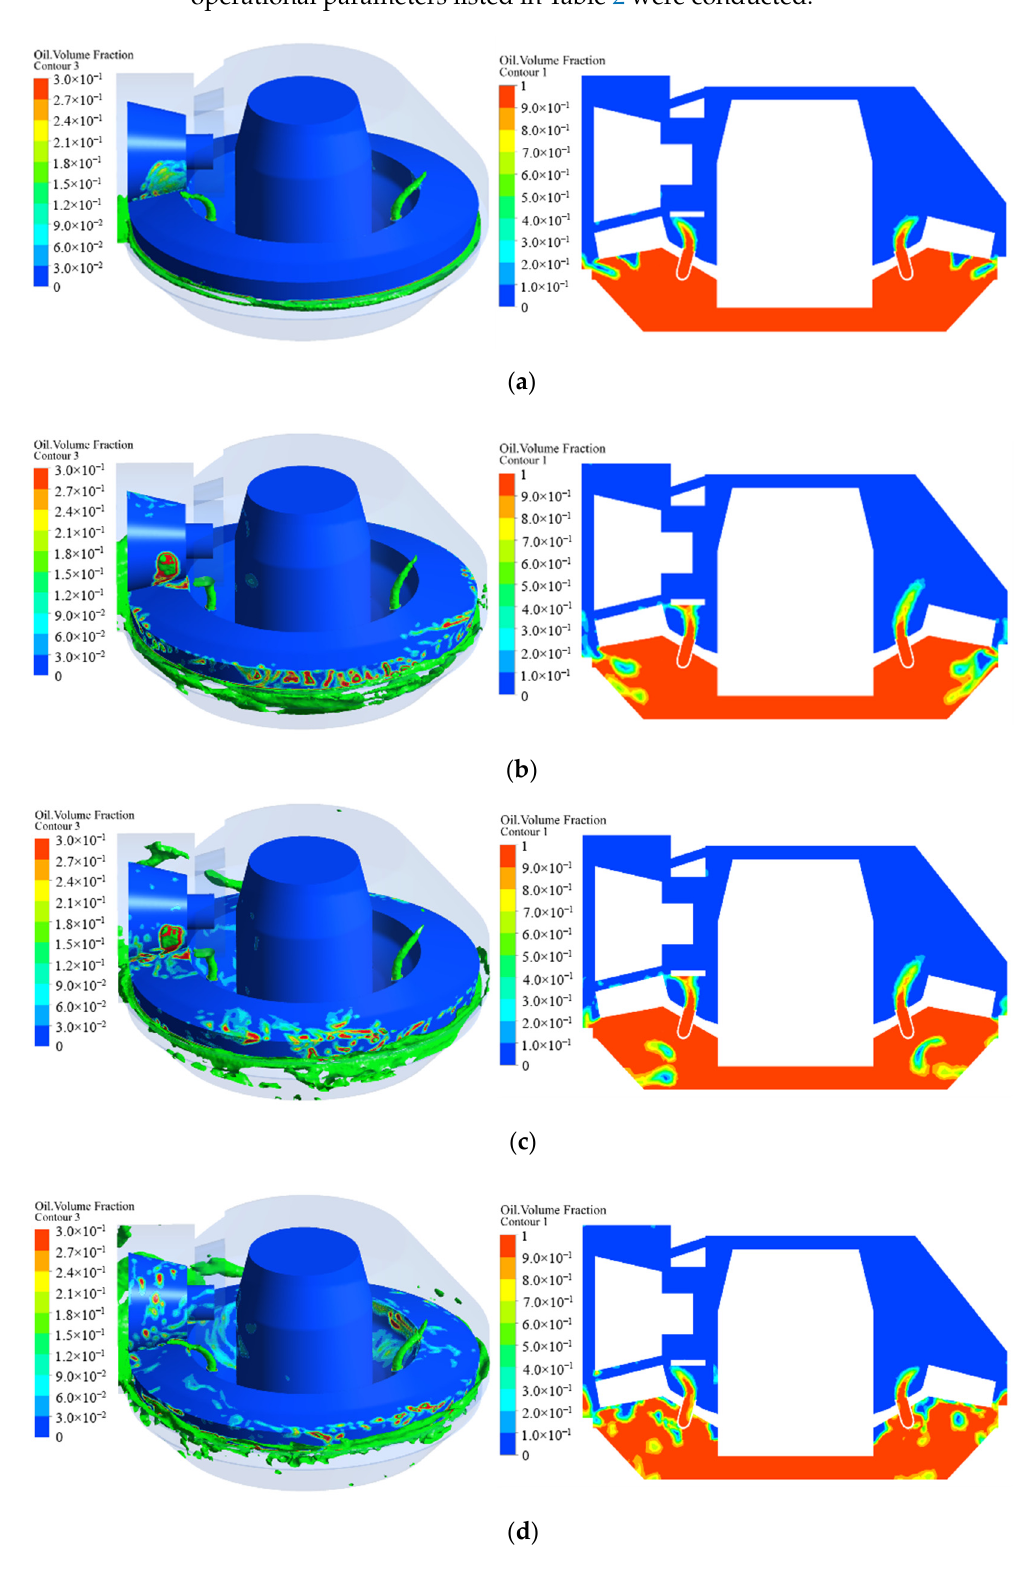
Figure 7. Instantaneous oil distribution inside the main gearbox: ( a ) R = 0.5 r; ( b ) R = 1.0 r; ( c ) R = 2.0 r; ( d ) R = 4.0 r.